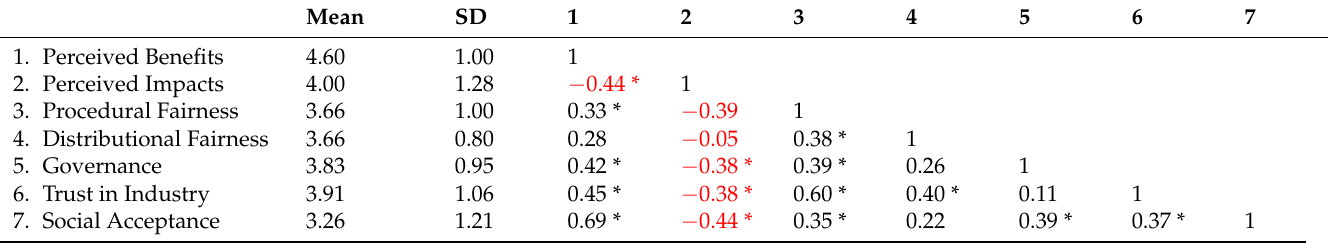
Table 2. Descriptive Statistics and bivariate Pearson correlations of the SLO variables (N =